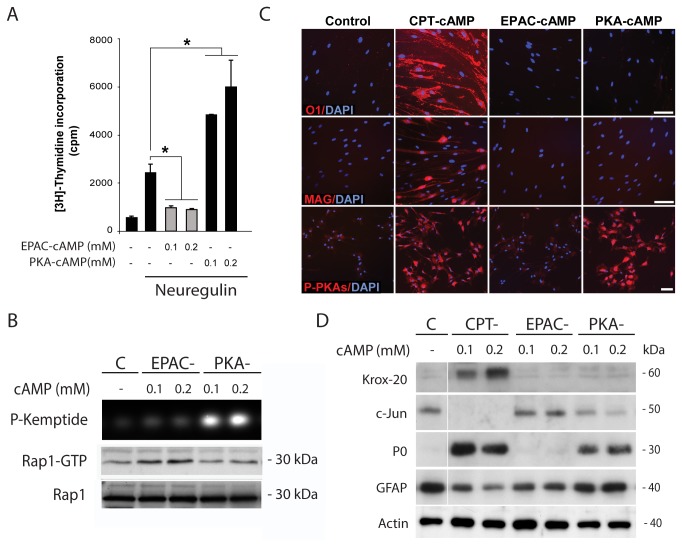
Effect of selective activation of EPAC and PKA on the proliferation and differentiation of isolated SCs.Cells were left untreated (control) or stimulated with CPT-cAMP, EPAC-cAMP or PKA-cAMP at a concentration of 200 µM each, unless otherwise indicated. Cells were analyzed for the incorporation of [3H]-thymidine (A) and the expression of myelin associated markers (C-D) 3 days after cAMP administration. The activity of PKA was determined by in
vitro phosphorylation assays (B, upper panel) and the immunodetection of phosphorylated PKA-specific substrates (C, bottom panels) in SCs stimulated for 30 min with the indicated analogs of cAMP. The activity of EPAC (Rap1 assays) was determined under identical experimental conditions (B, lower panels). As shown in C and D, EPAC-cAMP and PKA-cAMP failed to mimic the action of CPT-cAMP (Figure 5C) or db-cAMP (Figure 2) either if provided alone or in combination (not shown). Curiously, PKA-cAMP modestly increased P0 and reduced c-Jun expression without increasing Krox-20 or reducing GFAP expression (D).